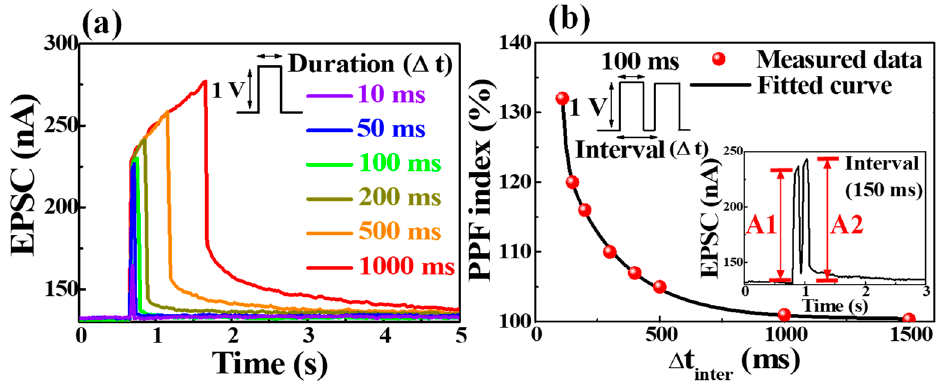
Figure 5. ( a ) EPSC retention characteristics of a single pre-synapse spike with duration (10 to 1000 ms) variation. ( b ) PPF index (A2/A1 × 100%) plotted as a function of spike interval times. The inset represents EPSC triggered by paired spikes at 100 ms intervals.